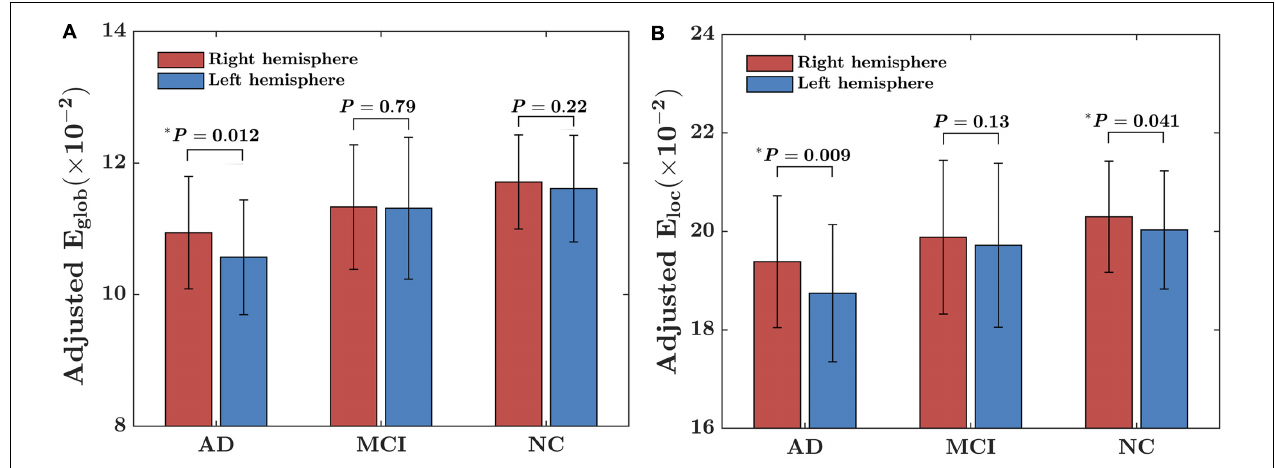
FIGURE 1 | Within-group asymmetry of the global and local network efficiency of the hemispheric networks. (A) Global network efficiency ( E glob ); (B) Local network efficiency ( E loc ). For each group, the statistical analysis was conducted after the data were adjusted for age, sex, hemispheric ICV, and TR and TE from diffusion-weighted imaging. ∗ indicates a significant difference between two hemispheres ( P < 0.05).